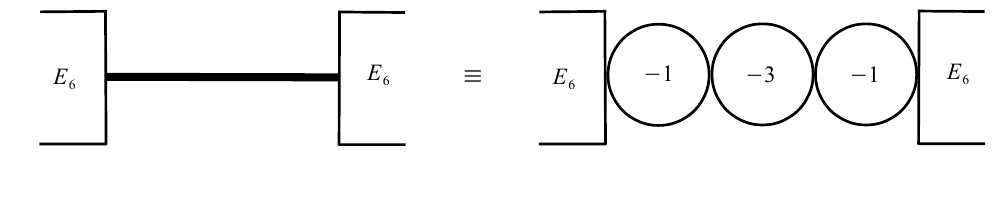
Figure 7. E 6 conformal